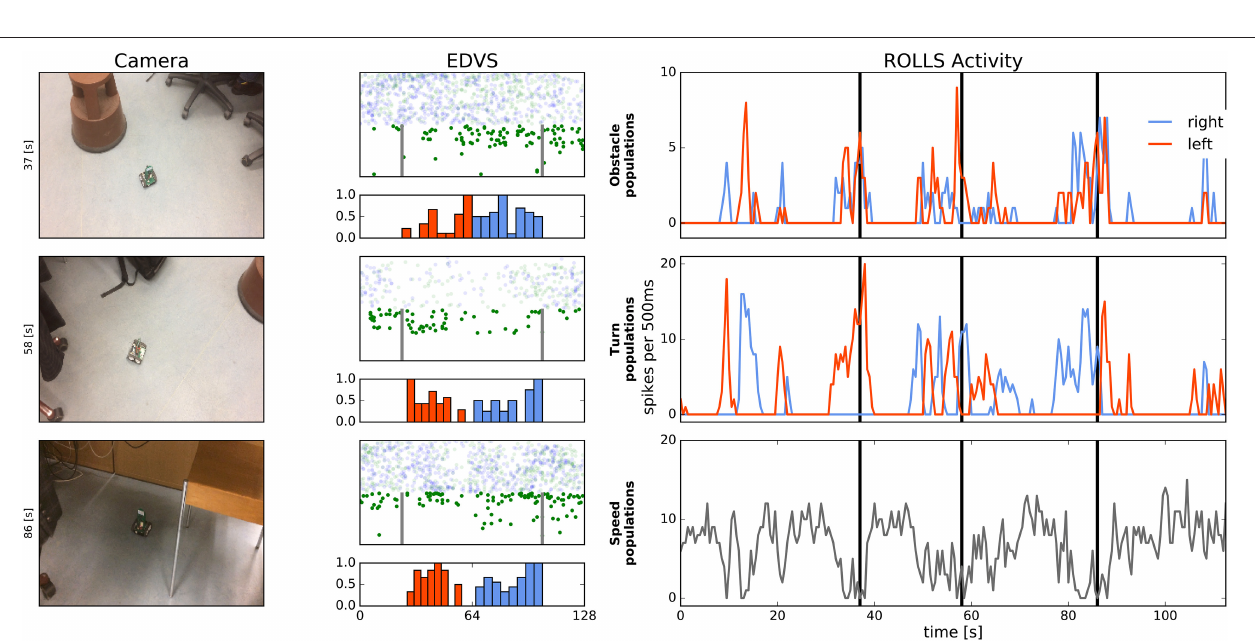
FIGURE 12 | Variability of the robot’s behavior. Left: Overlay of video camera frames recording the robot, avoiding a pair of obstacles; top view. Three different trials are recorded and overlayed here (trajectories are shown with green lines 1–3). Right: Velocity commands, received by the robot from the neuronal architecture (angular velocity and speed) for the three trials (from top to bottom).